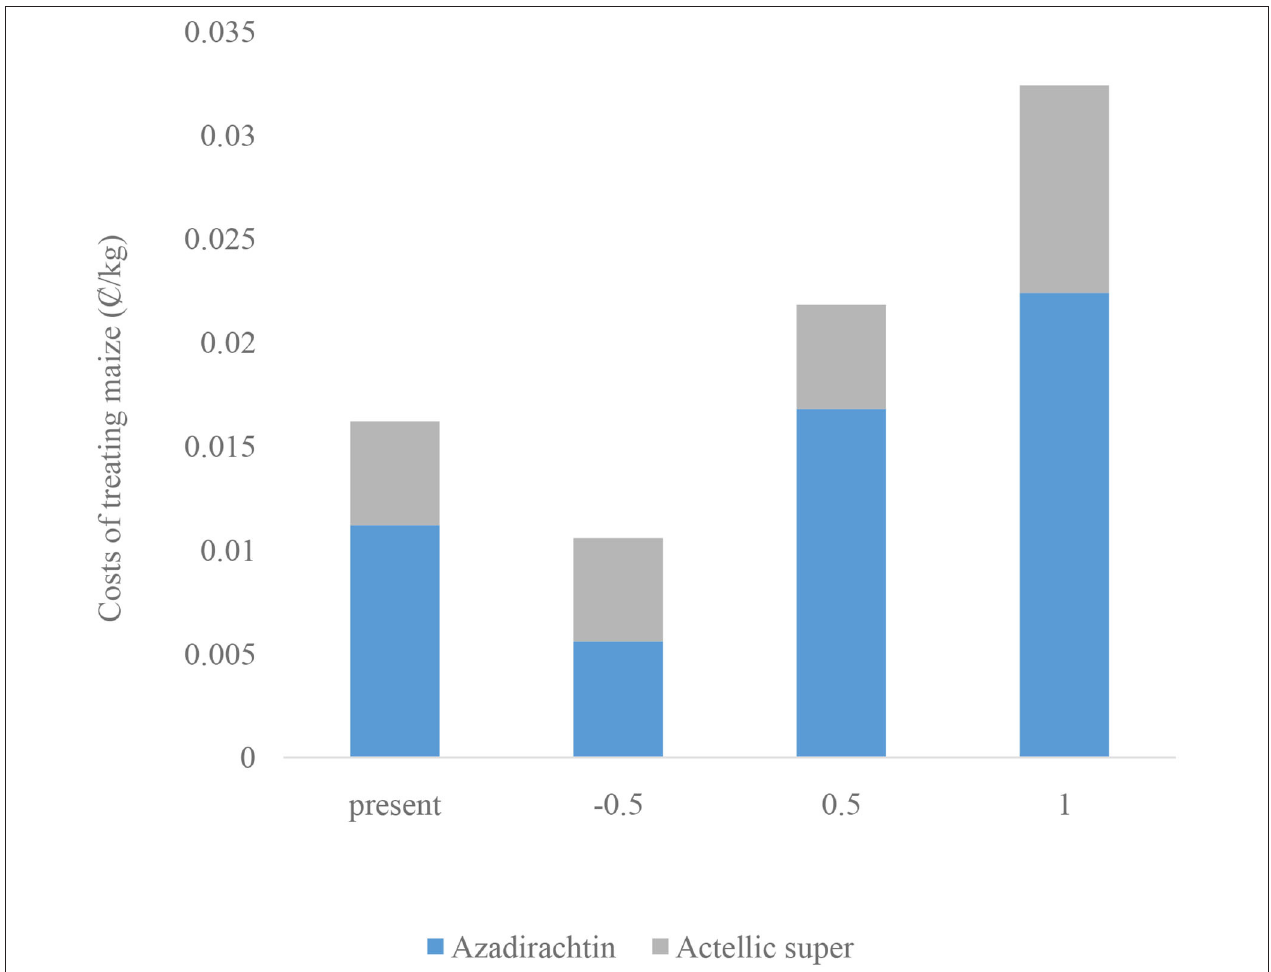
FIGURE 5 | The costs of azadirachtin and actellic super per treatment of 1kg of maize at the present price, and dollar-to-cedi exchange rate and an inflation rate of minus 50%, plus 50%, and plus 100% (generated using Microsoft Excel).